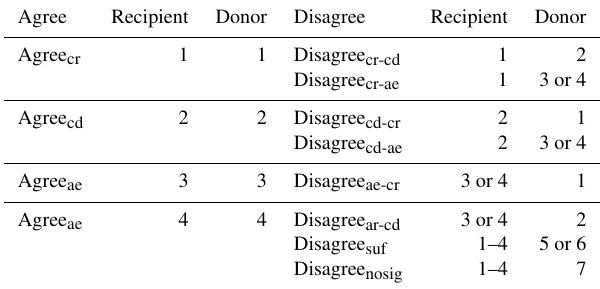
Table 1. Contingency tables for the comparison of the reconstructed profile using SRM method to CALIPSO VFM